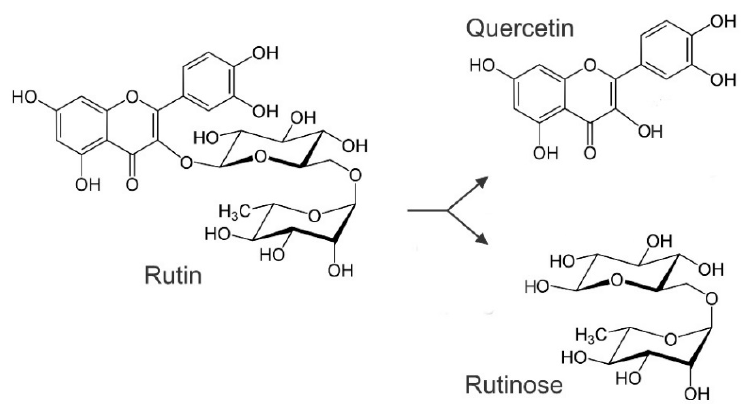
Figure 5. Transformation of flavonoid rutin to aglycone quercetin and rutinose. The extraction of rutin from buckwheat samples is more effective with around 70% ethanol than extraction with more concentrated solvent [38]. This is probably due to the sugar part of the rutin molecule. As rutin and other phenolic substances can be bound to different compounds and grain structures, effective extraction can take several hours [39–41]. After milling the Tartary buckwheat grain and mixing the milled product with water, the flavonoid quercetin is obtained in the flour–water mixture, a result of rutin degradation by rutinosidase [41–45]. Heating by hot water or steam inactivates the rutin- degrading enzymes in buckwheat flour. On the contrary, after dry heating buckwheat flour at 150 ◦ C by infrared radiation, the rutin-degrading enzymes remain active for 40 min [46]. Lactic acid bacteria can also split flavonoid glycosides into flavonoid aglycones and sugar.